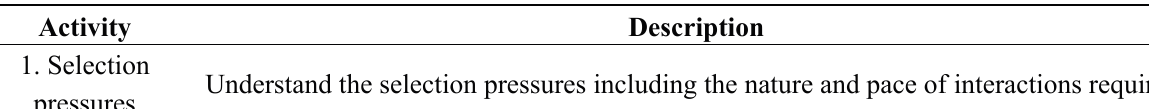
Table 5. Activities for Connecting Digital Information and